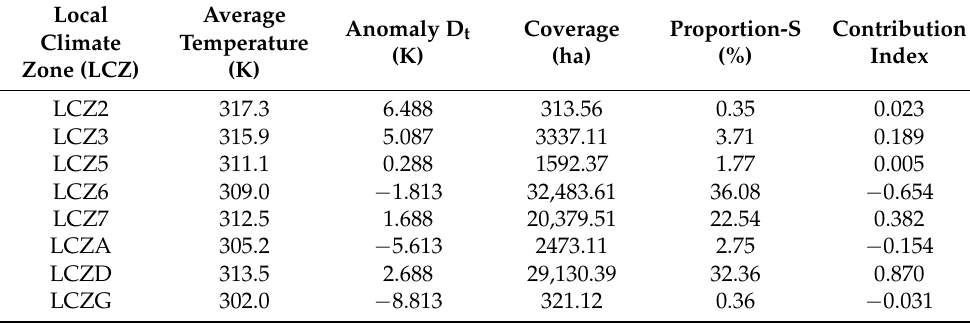
Table 3. Contribution of LCZs to the warming and cooling of the city.